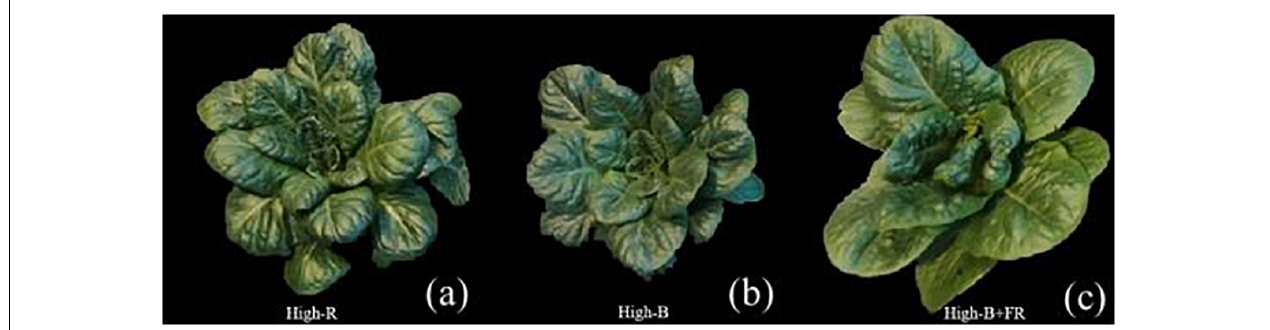
FIGURE 3 | Representative romaine lettuce plants from different light treatments. (a) High-R, (b) High-B, and (c) High-B+FR treatments. See Table 1 for a description of treatments.